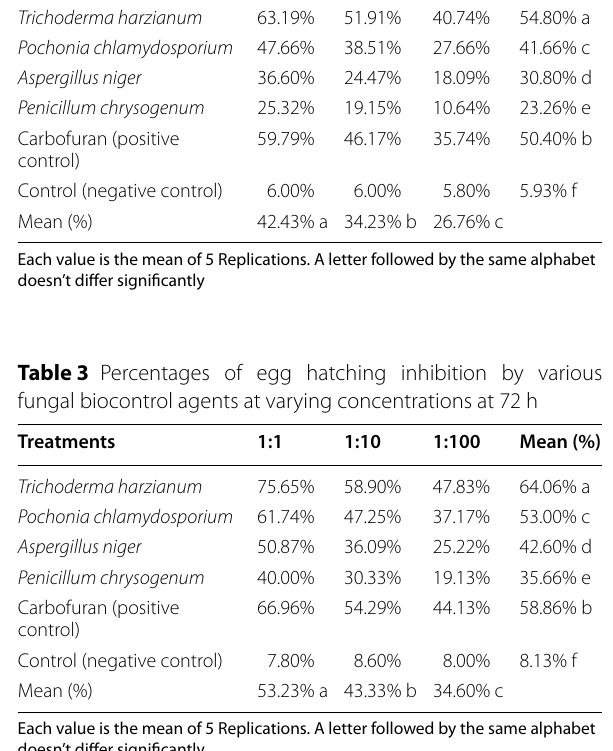
Table 2 Percentages of egg hatching inhibition by various fungal biocontrol agents at varying concentrations at 48 h Treatments